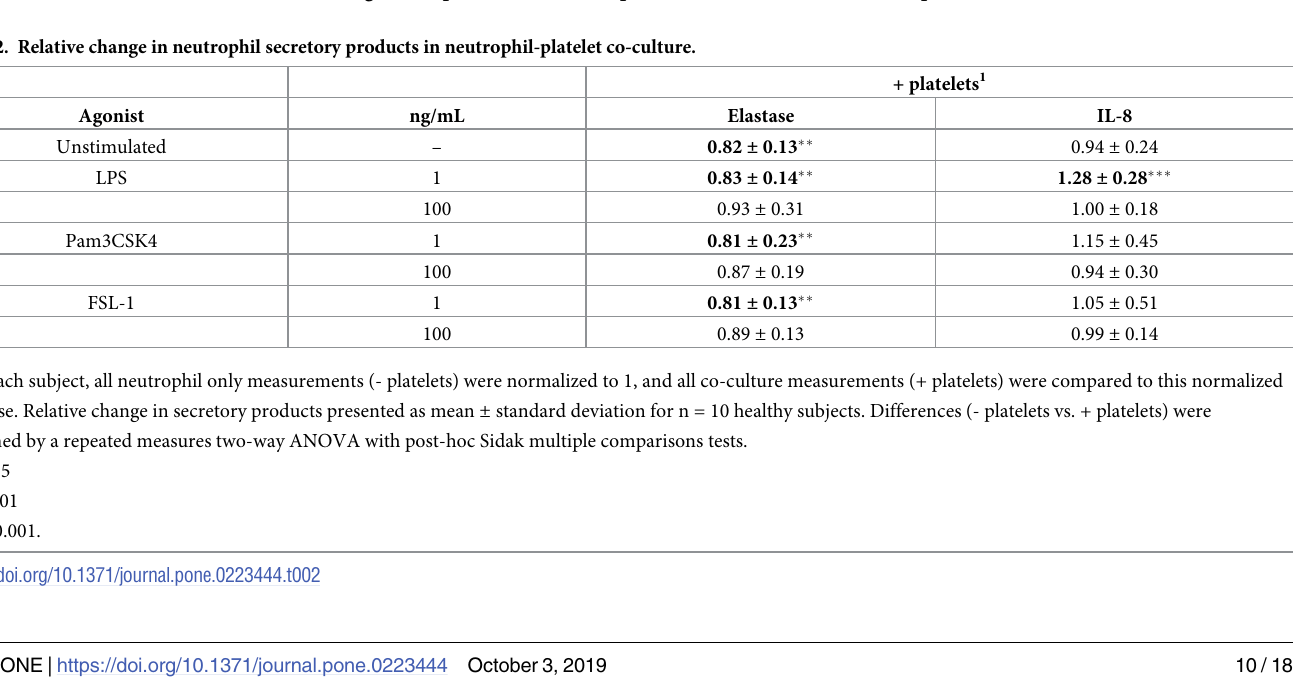
Table 2. Relative change in neutrophil secretory products in neutrophil-platelet co-culture. Agonist ng/mL Elastase IL-8 Unstimulated